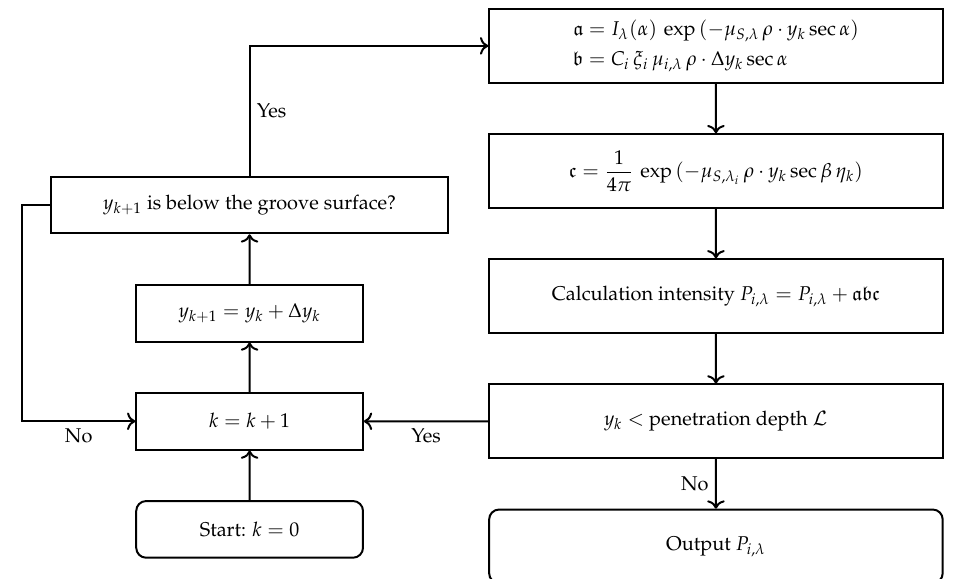
Figure 9. Flow chart depicting the numerical calculation for the particle size effect in X-ray